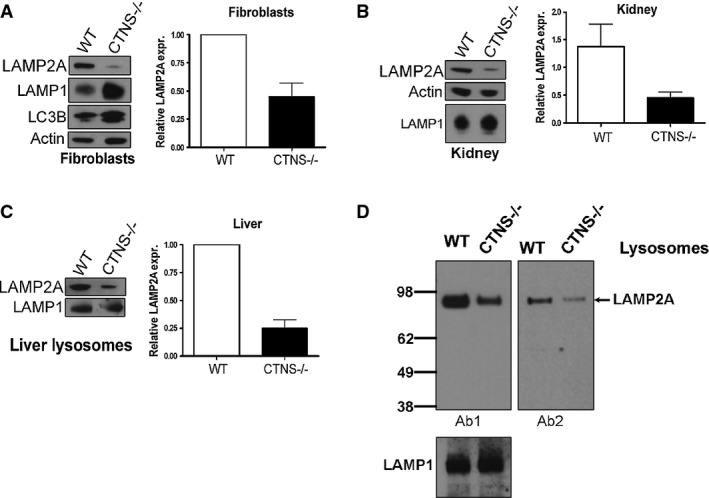
The CMA receptor LAMP2A is downregulated in CTNS-deficient cells
The expression levels of the endogenous LAMP2A and LAMP1 proteins were analyzed in wild-type (WT) and Ctns−/− mouse fibroblasts (A), kidney (B) and liver lysosomes (C) by Western blot. Quantitative densitometry analysis of immunoblots obtained from different experiments was performed by calculating the ratio between LAMP2A and actin signals in each lane. Results are mean ± SEM of four independent experiments with mouse fibroblasts, 5 WT and 6 Ctns−/− mouse kidneys, 3 WT and 3 Ctns−/− mouse livers (lysosomal extracts).

Comparative analysis of the amount of LAMP2A in wild-type or Ctns−/− liver lysosomes was performed using two different anti-LAMP2A antibodies. 15 μg of lysosomal proteins were loaded in each lane. Ab1, anti-LAMP2A antibody raised against the twelve amino acids of the cytosolic region of rat LAMP2A largely validated to recognize mouse LAMP2A but not other LAMP2 isoforms (Cuervo & Dice, 1996). Ab2, anti-LAMP2A Abcam Ab18528. Decreased lysosomal LAMP2A was evident using either antibody. LAMP1 was used as a loading control. Representative of two independent experiments with similar results.
Source data are available online for this figure.